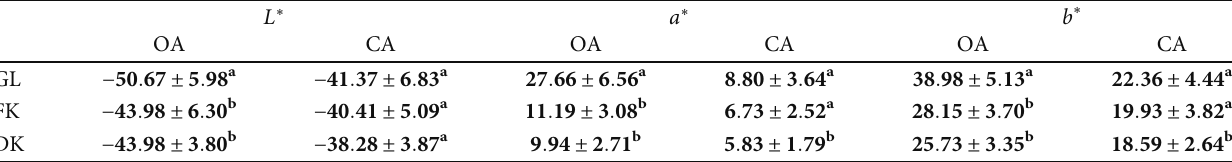
Table 1: E ff ects of diet on the muscle chromatic value in H. gigantea for 12months culture ( Mean ± SD ). L